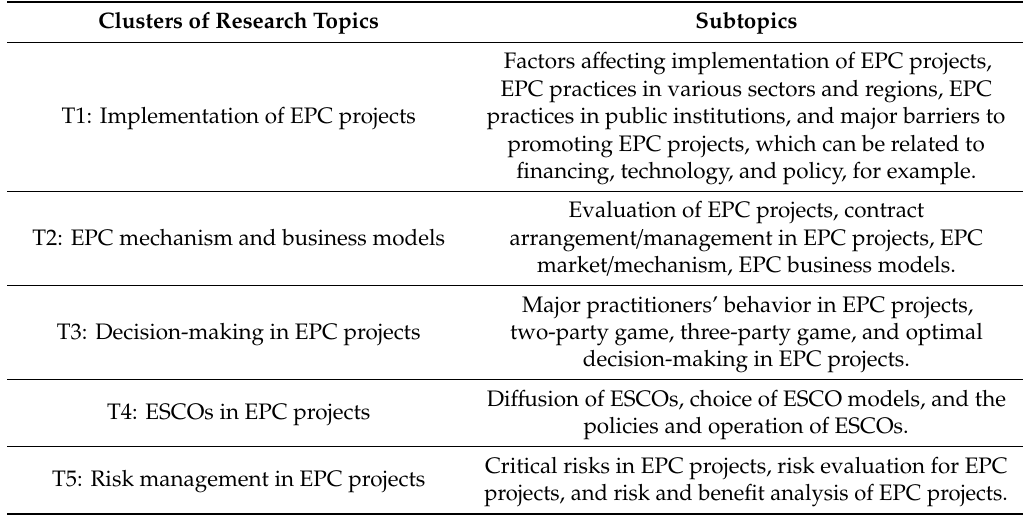
Table 3. Research topics in the 127 papers.